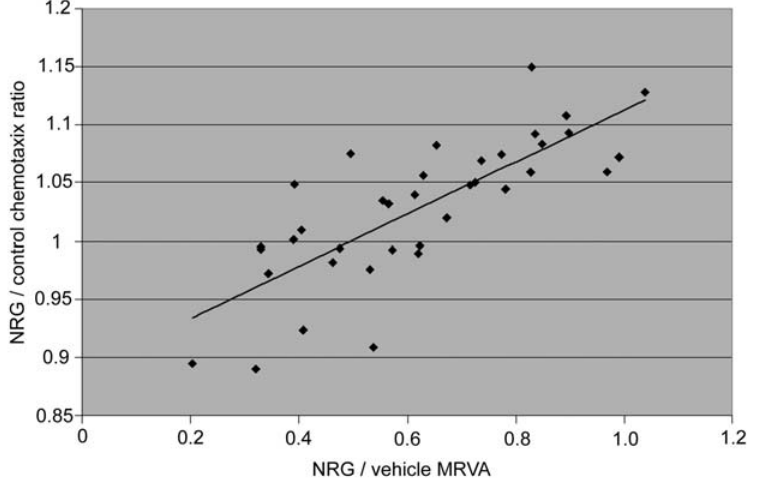
Figure 2. The maximum range of NRG1 a -induced varying adhesion predicts NRG1 a -induced chemotactic migration. Adhesion data were compared with available data gathered one year previously of NRG1 a -induced migration of those same cell lines.